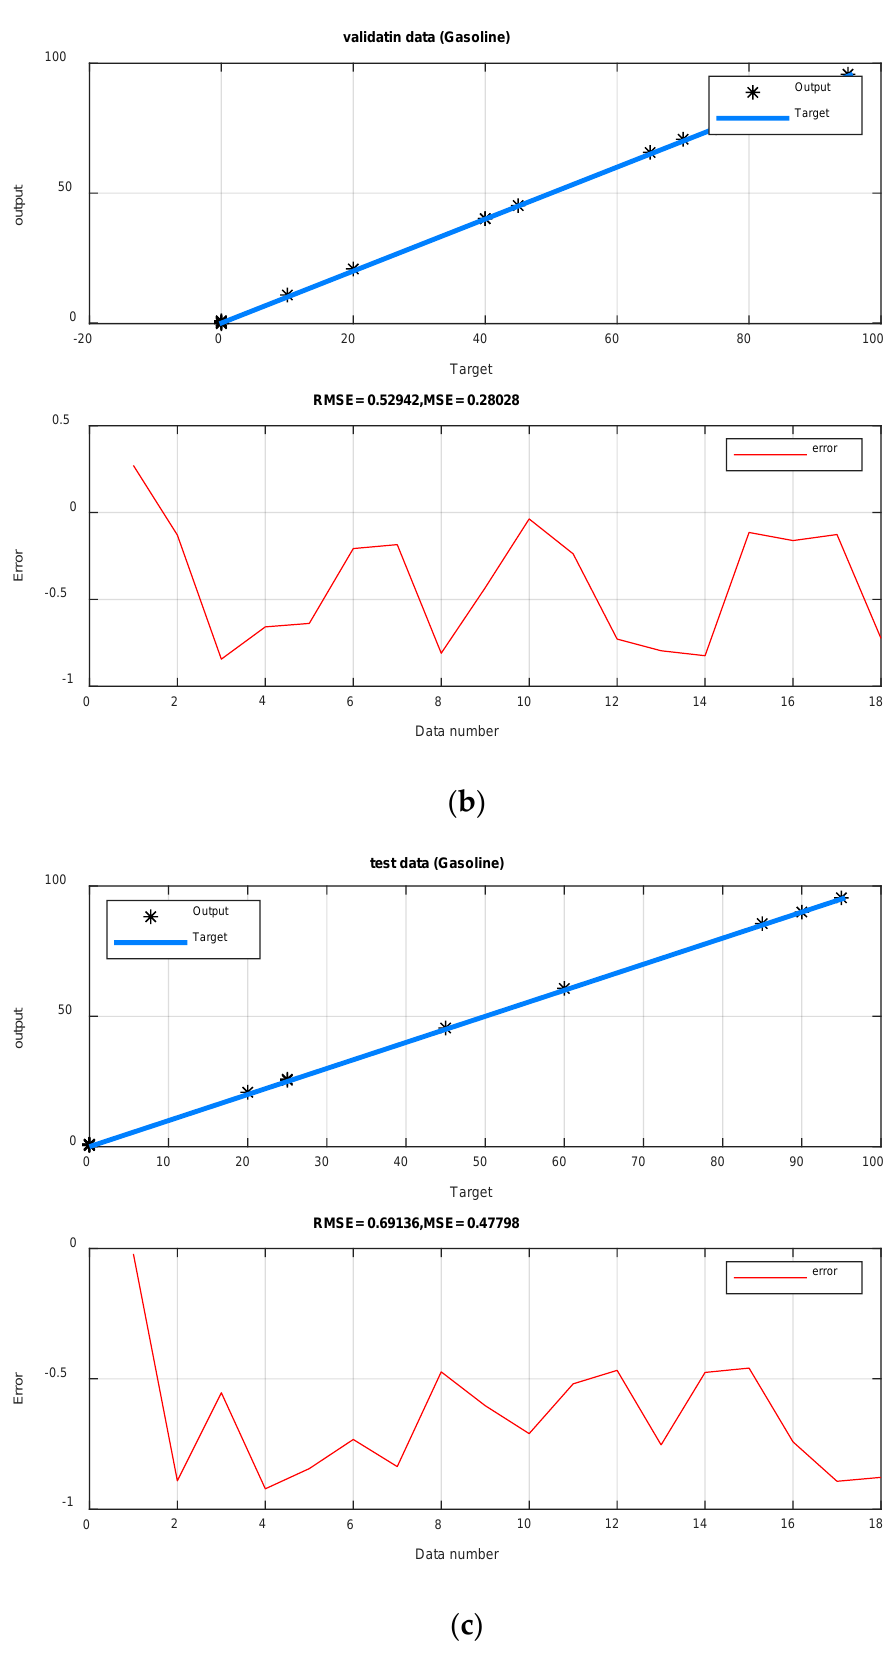
Figure 7. Network performance for predicting the volume rate of gasoline: ( a ) training, ( b ) validation, and ( c ) testing dataset.